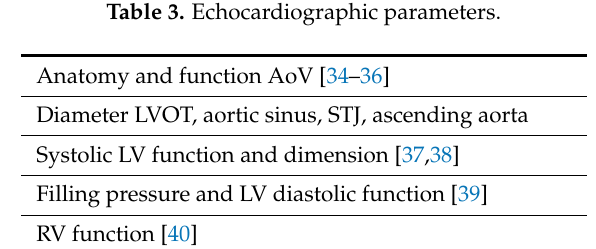
Table 3. Echocardiographic